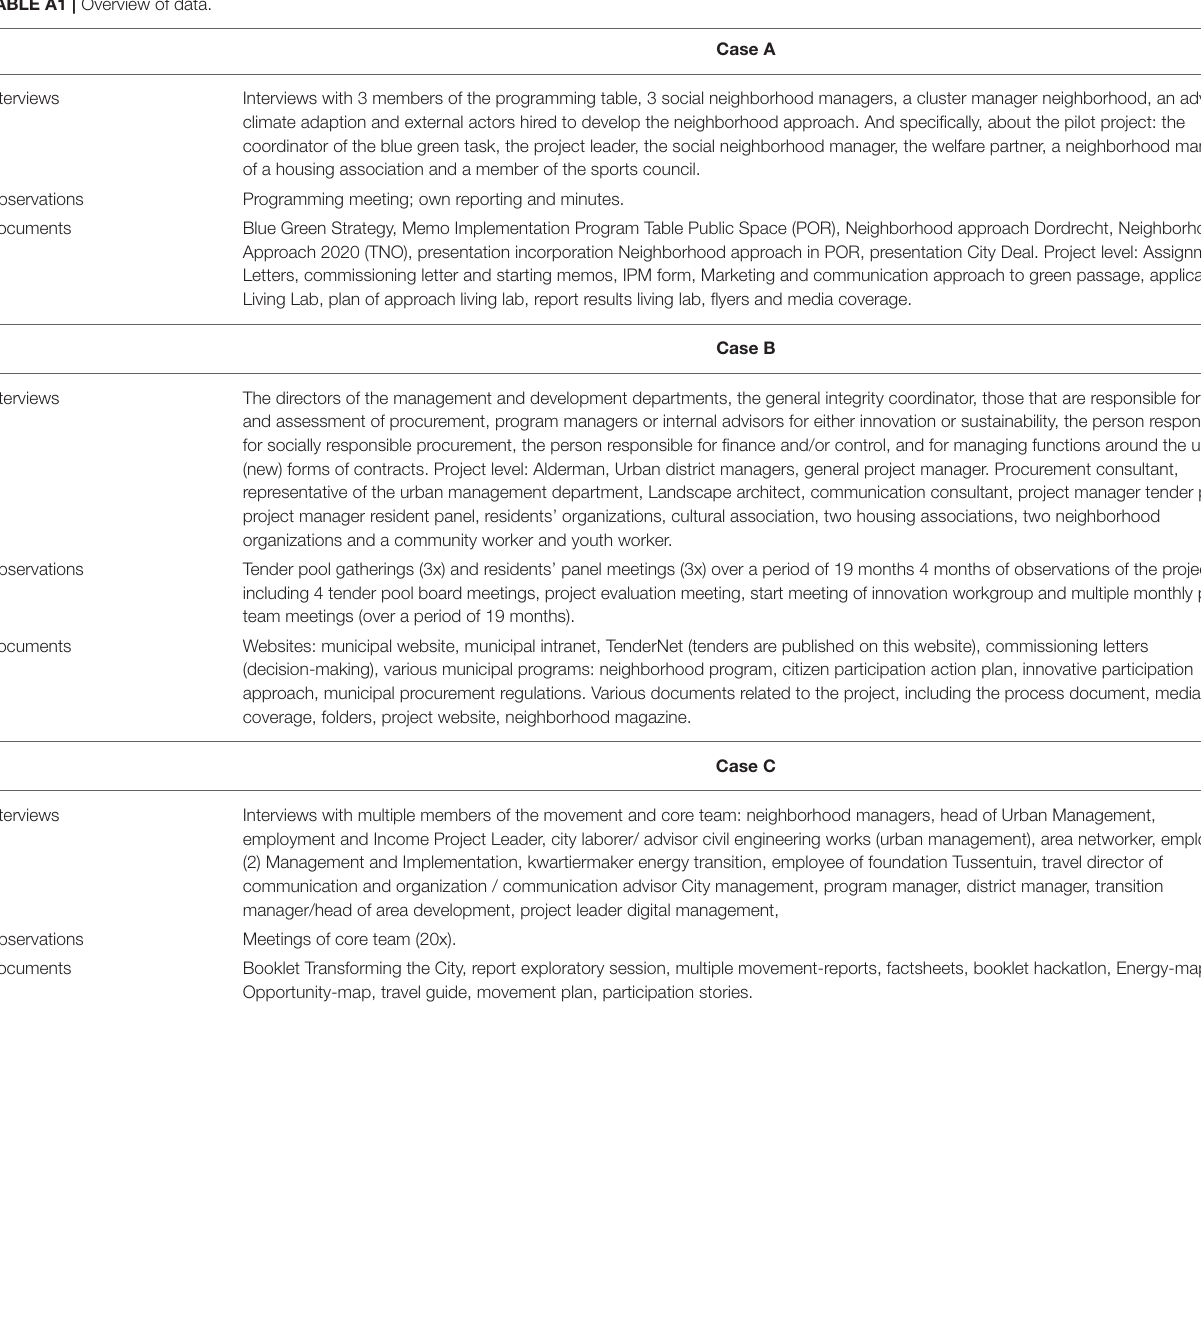
TABLE A1 | Overview of